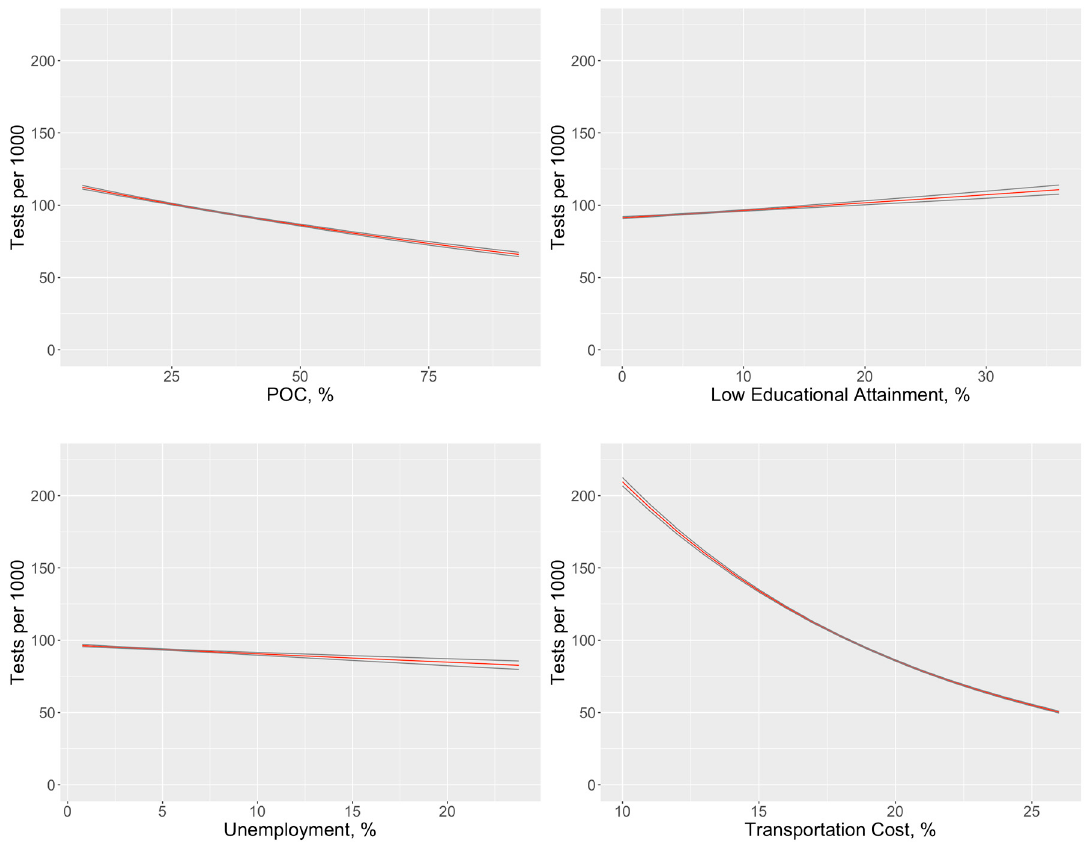
Figure 4. Influence of community-level factors on testing rates, adjusting for other factors in the multivariate model, with main estimate shown in black and the 95% CI in red.